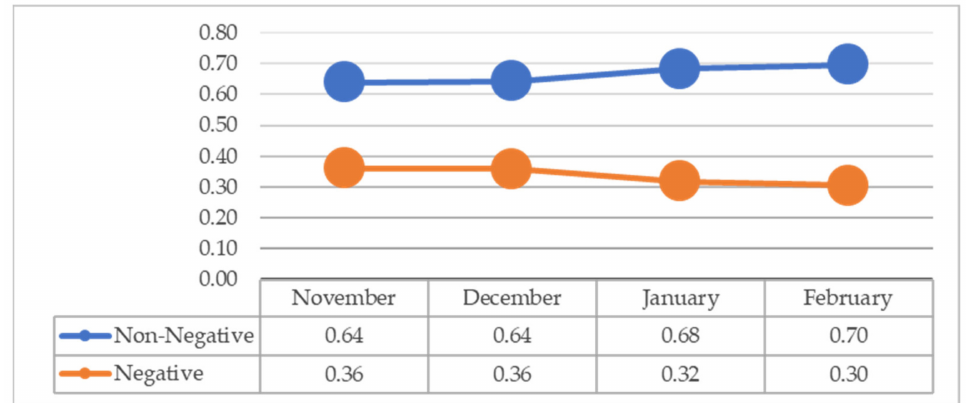
Figure 2. The rate of negative and non-negative tweets from November 2020 to February